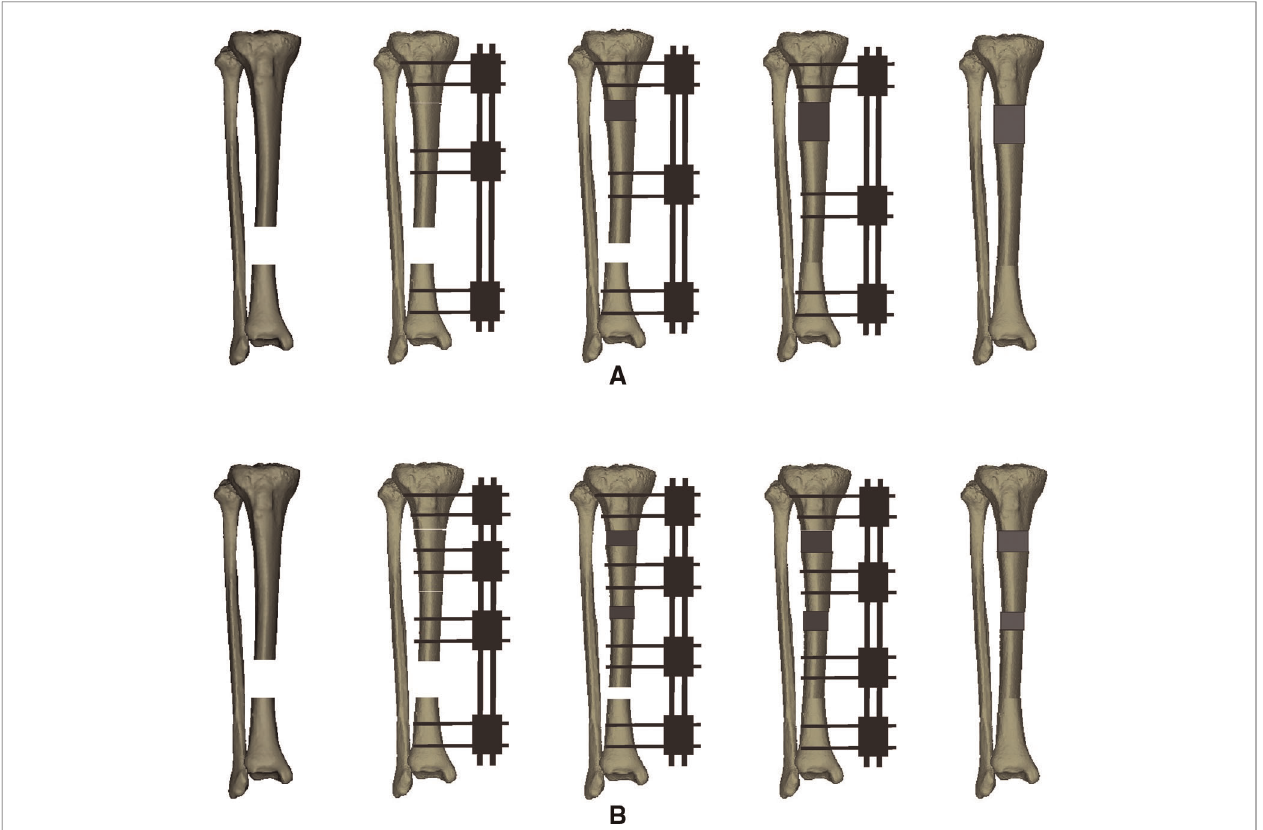
FIGURE 1 | Schematic diagram of the two bone transport techniques for the management of the lower third bony segmental defects in the tibia (from left to right). ( A ) Bifocal bone transport technique. ( B ) Trifocal bone transport